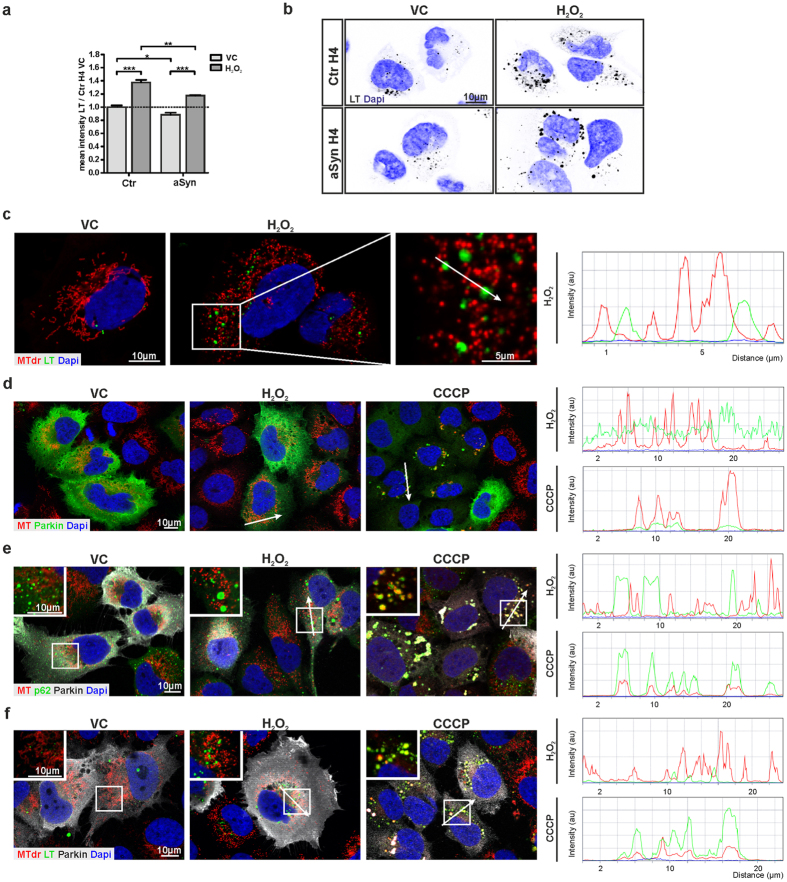
Mitosphere formation is not linked to Parkin-related mitophagy.(a,b) OS led to an upregulation of LysoTracker Red (LT)-positive structures as investigated via flow cytometry (a) and fluorescence microscopy (b) in aSyn and Ctr H4 cells treated with 300 μM H2O2 for 4 h. (a) The relative mean cellular intensity of the LT signal compared to VC-treated Ctr H4 cells is shown (Two-way ANOVA Bonferroni’s Multiple Comparison Test, n = 3, F = 131.5, p < 0.0001 (VC vs. H2O2); F = 29.68, p = 0.0006 (Ctr vs. aSyn)). (c) MTdr-stained mitospheres did not show co-localization with LT-positive organelles as investigated via fluorescence microscopy 4 h after the treatment with 300 μM H2O2. Intensity profiles, along the white arrows, of the MTdr (red) and LT (green) staining are depicted. (d–f) H4 cells transiently overexpressing Parkin were treated for 4 h with 300 μM H2O2 or 50 μM CCCP as control. Parkin (d) and p62 recruitment (e) as well as co-localization of mitochondria and LT-positive organelles (f) was investigated via fluorescence staining. In contrast to mitochondria of CCCP-treated cells, H2O2-induced mitospheres did not show co-labeling with Parkin, p62 or LT. The red color of the intensity profiles along the white arrows reflects the MT or MTdr staining, the green color represents Parkin, p62 and LT staining in (d–f) respectively.